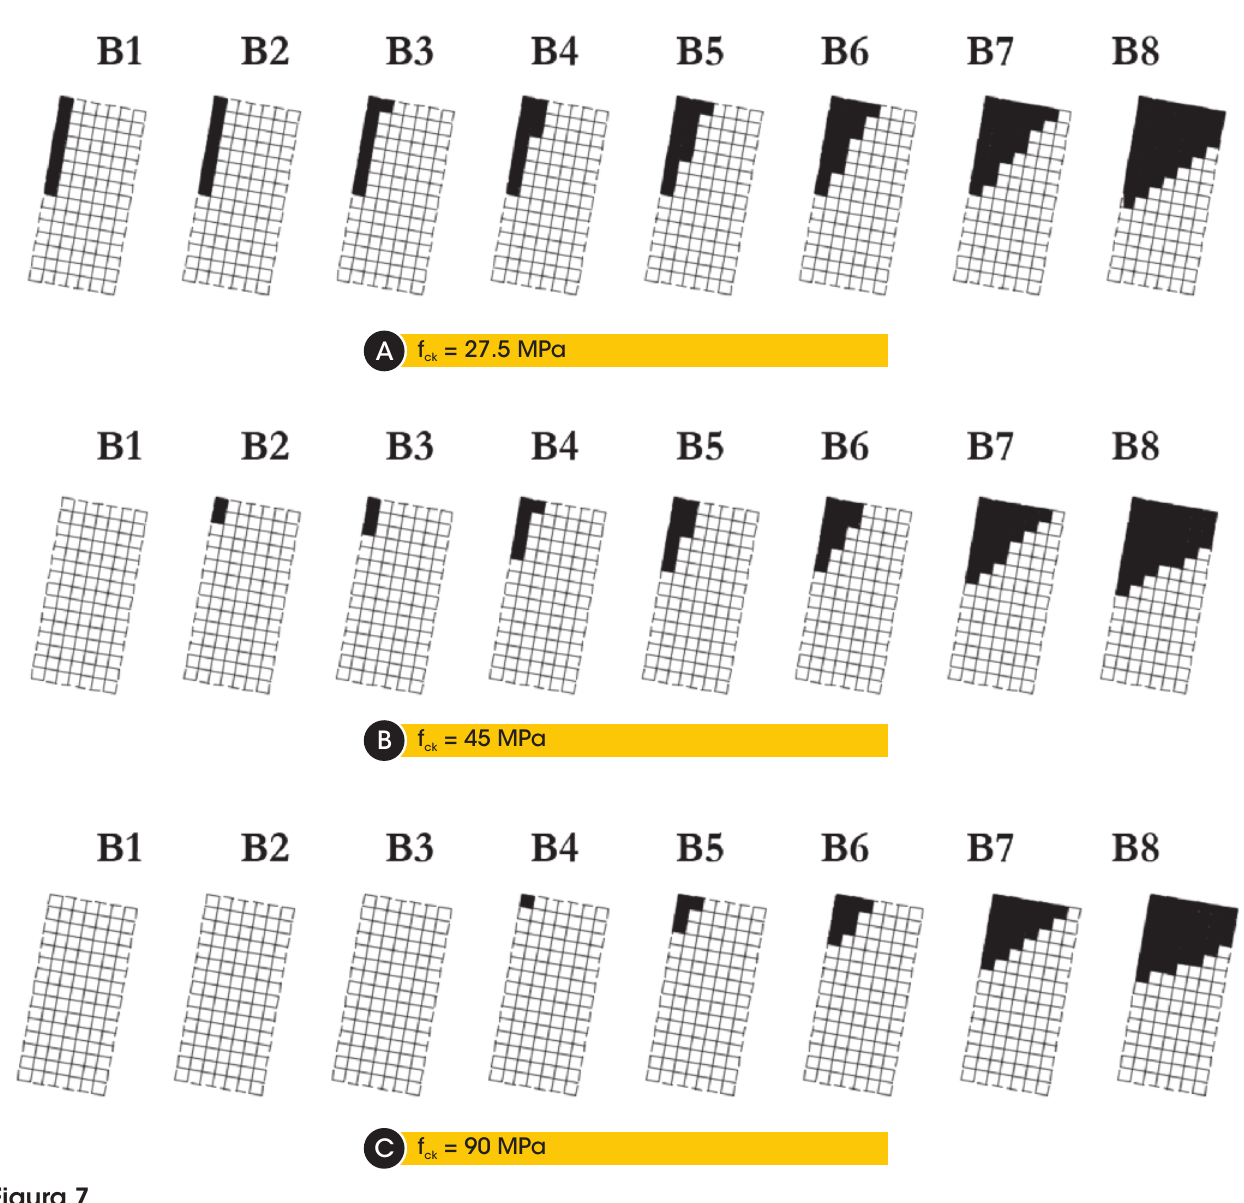
Figura 7 Perda de contato na almofada A Fonte: Autores